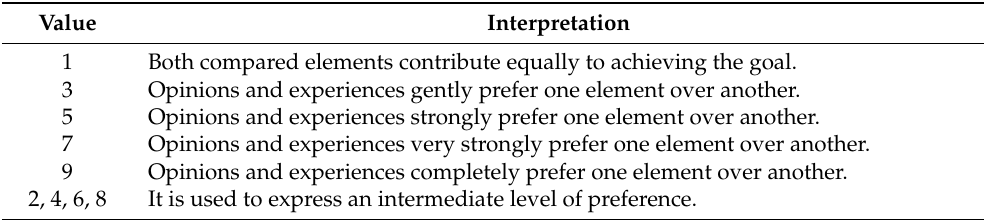
Table 13. Factors’ preference possible choices for decision